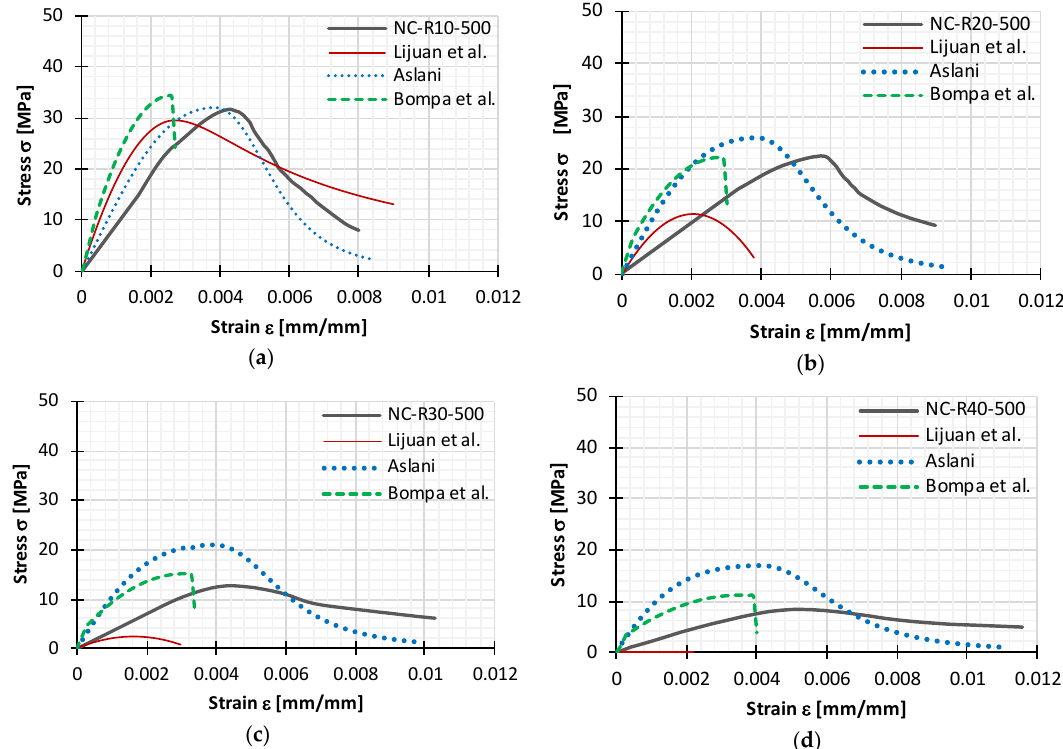
Figure 10. Comparison of experimental stress-strain curves for ( a ) NC-R10-500; ( b ) NC-R20-500; ( c ) NC-R30-500; and ( d ) NC-R40-500 with existing constitutive models. Table 6. Comparison of experimentally and analytically obtained results of peak stress 𝑓 𝑟𝑐 and strain 𝜀 𝑟𝑐 of rubberized concrete.